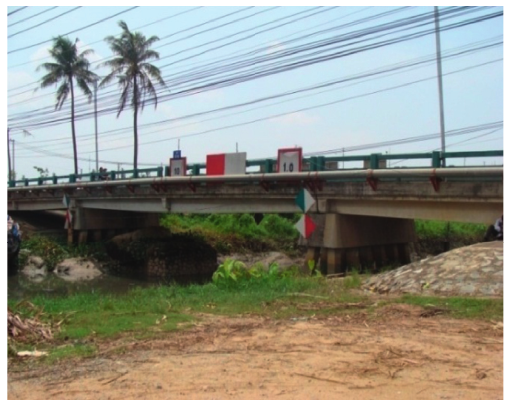
Figure 7: Picture of Ben Noc bridge in practice.